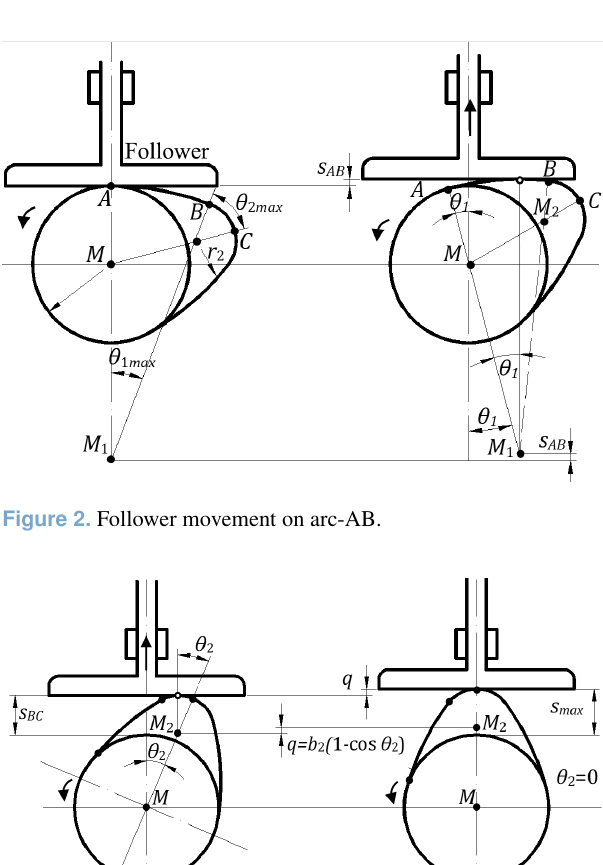
Figure 4. Cam follower